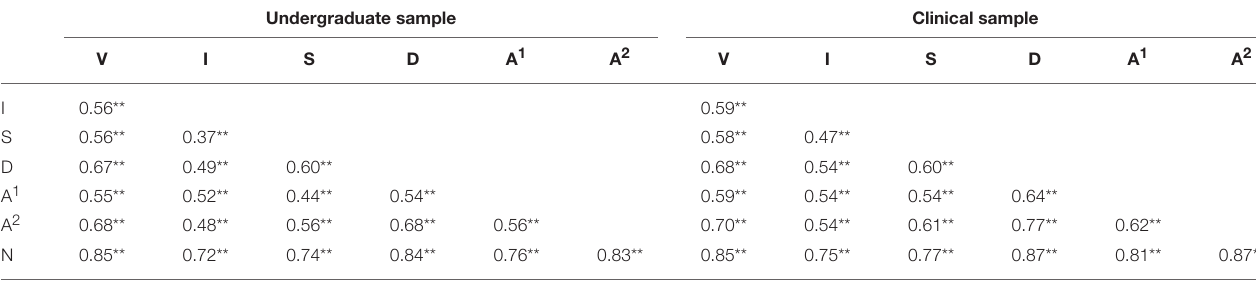
TABLE 5 | Intercorrelations among total neuroticism subscale and its six facets. Undergraduate sample Clinical sample